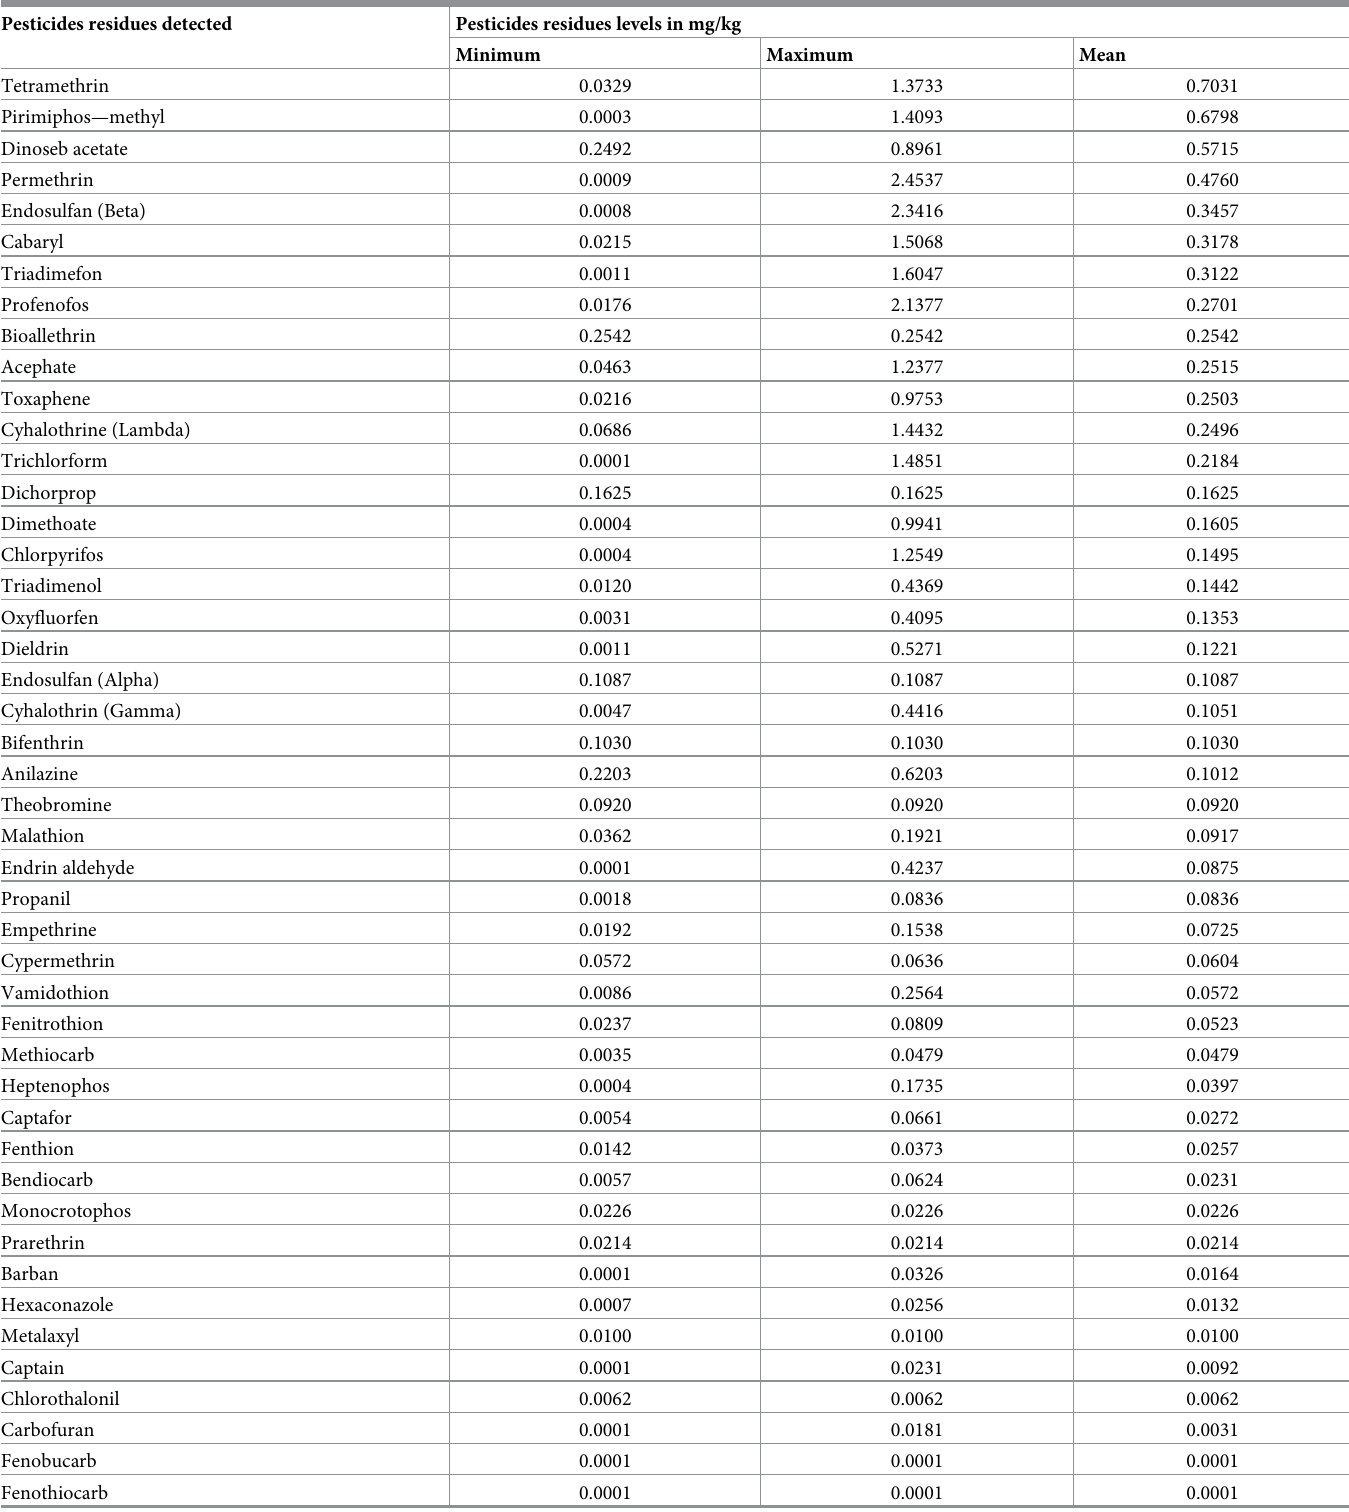
Table 4. Concentration of pesticides residues